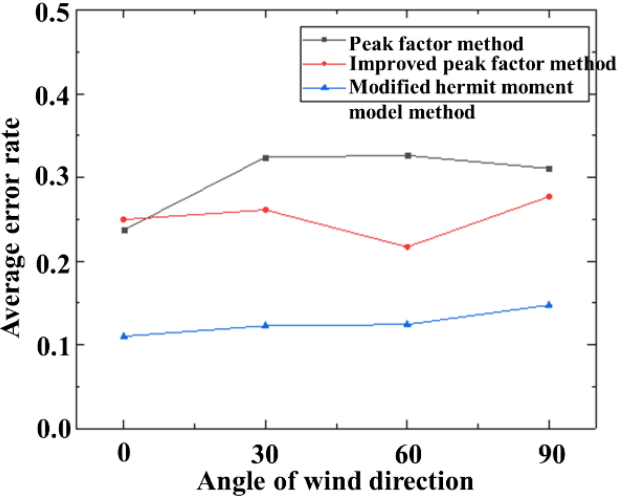
Figure 13. Average error rate of three methods for estimating the maximum value of wind pressure coefficient.